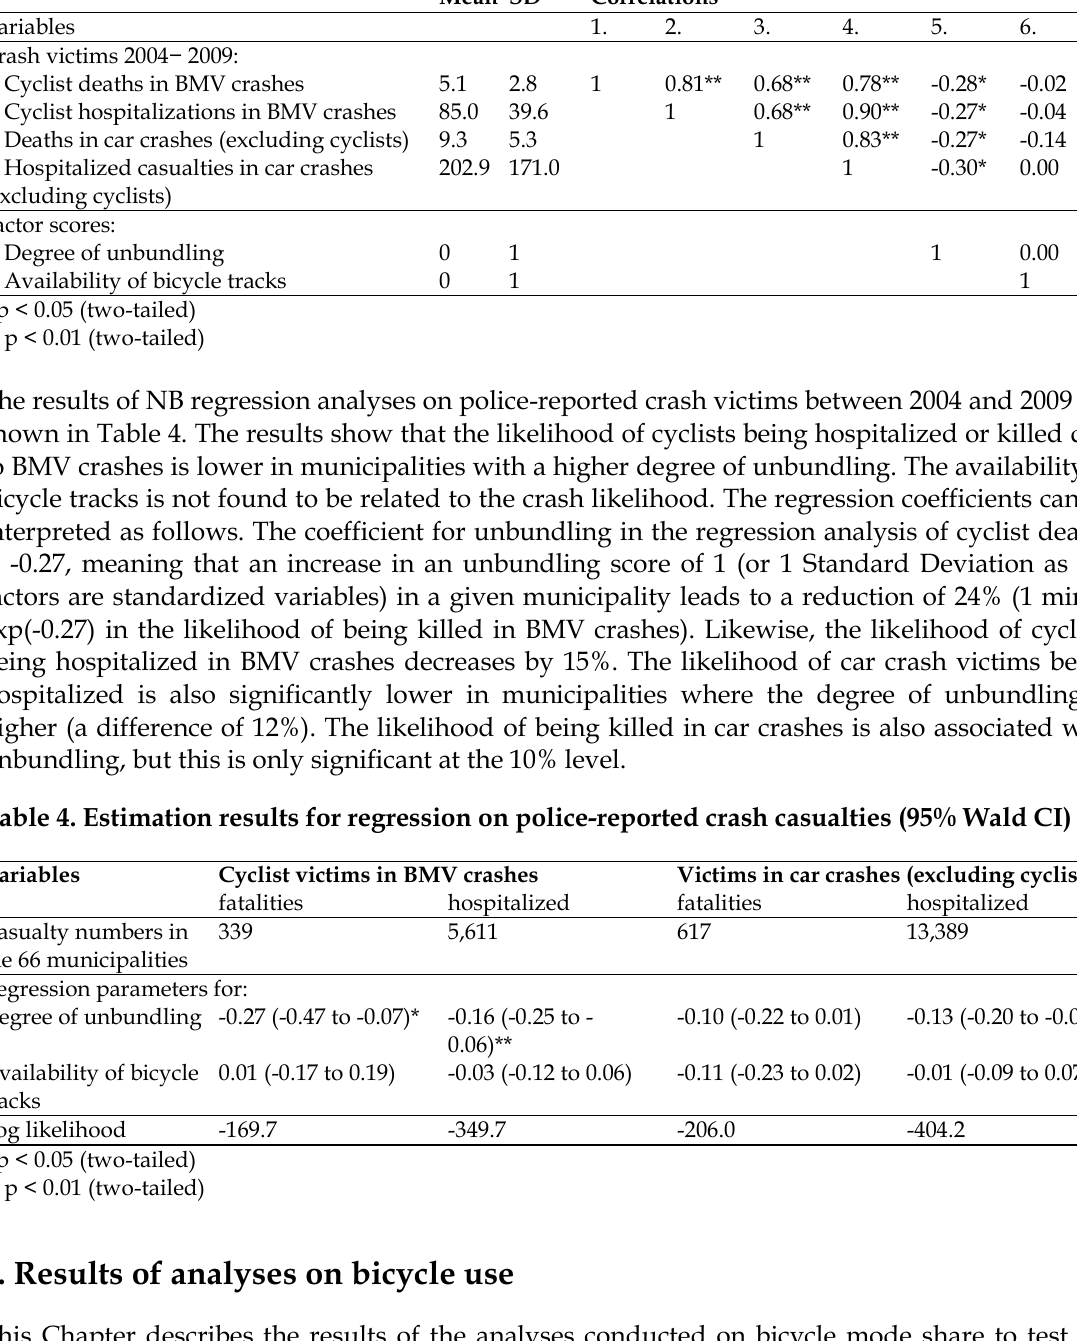
Table 3. Descriptive Statistics for the Variables Used in the Crash Analyses Mean SD